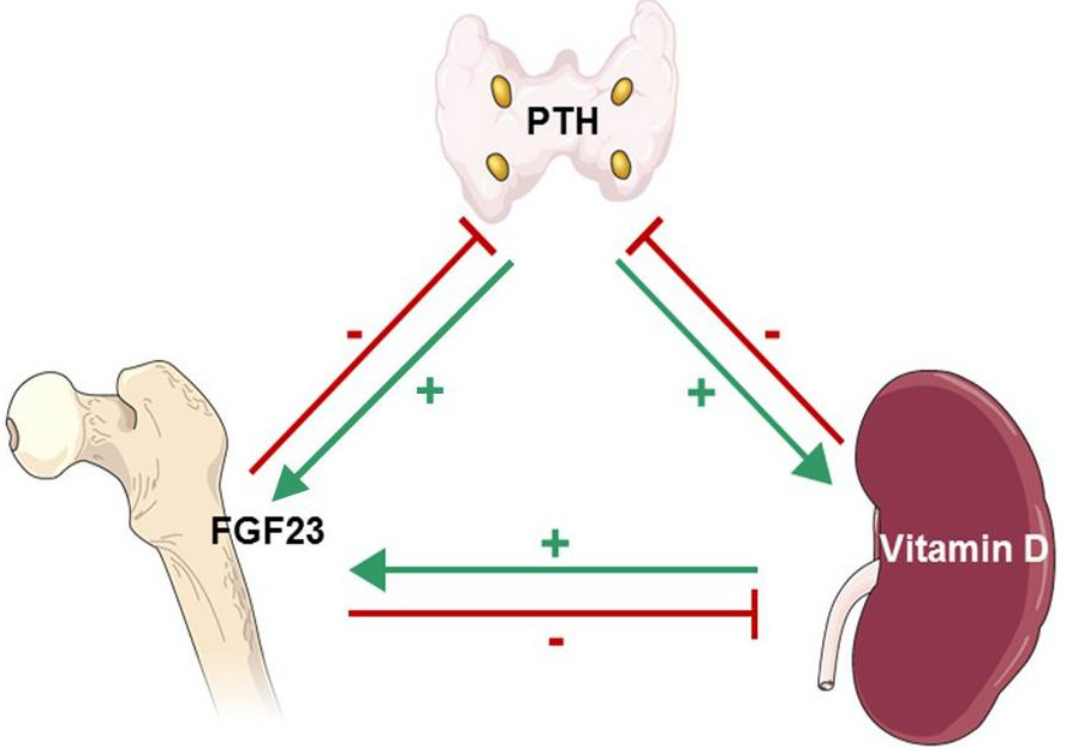
Figure 2. Interplay of PTH, FGF23 and active vitamin D: PTH increases bone FGF23 gene expression [96] (Green, Parathyroid Gland→Bone) and kidney proximal tubule 1α-hydroxylation of 25(OH)D [97] (Green, Parathyroid Gland→Kidney). 1,25(OH)D2 (active vitamin D) binds to parathyroid vitamin D receptor (VDR), inhibiting PTH gene transcription [95] (Red, Kidney→Parathyroid Gland) and stimulates osteoblast and osteoclast FGF23 production [98] (Green, Kidney→Bone). FGF23 increases parathyroid CSR and VDR expression, inhibiting PTH production [99] (Red, Bone→Parathyroid Gland). FGF23 also decreases kidney proximal tubule 1α-hydroxylation, reducing vitamin D activation, and increases kidney (and liver) 24-hydroxylation of 25(OH)D, enhancing vitamin D inactivation [100] (Red,